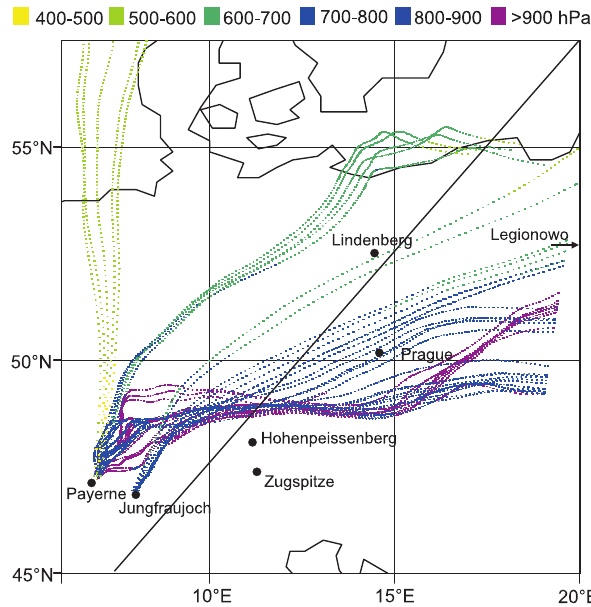
Fig. 12. 48-h backward trajectories (ensembles) from DWD/SM for 17 March, 0 UTC, arriving at Chaumont, Jungfraujoch, and Payerne at various levels. The line indicates the cross section used in Fig. 15. The locations of the sounding sites used in Fig. 14 are also displayed.